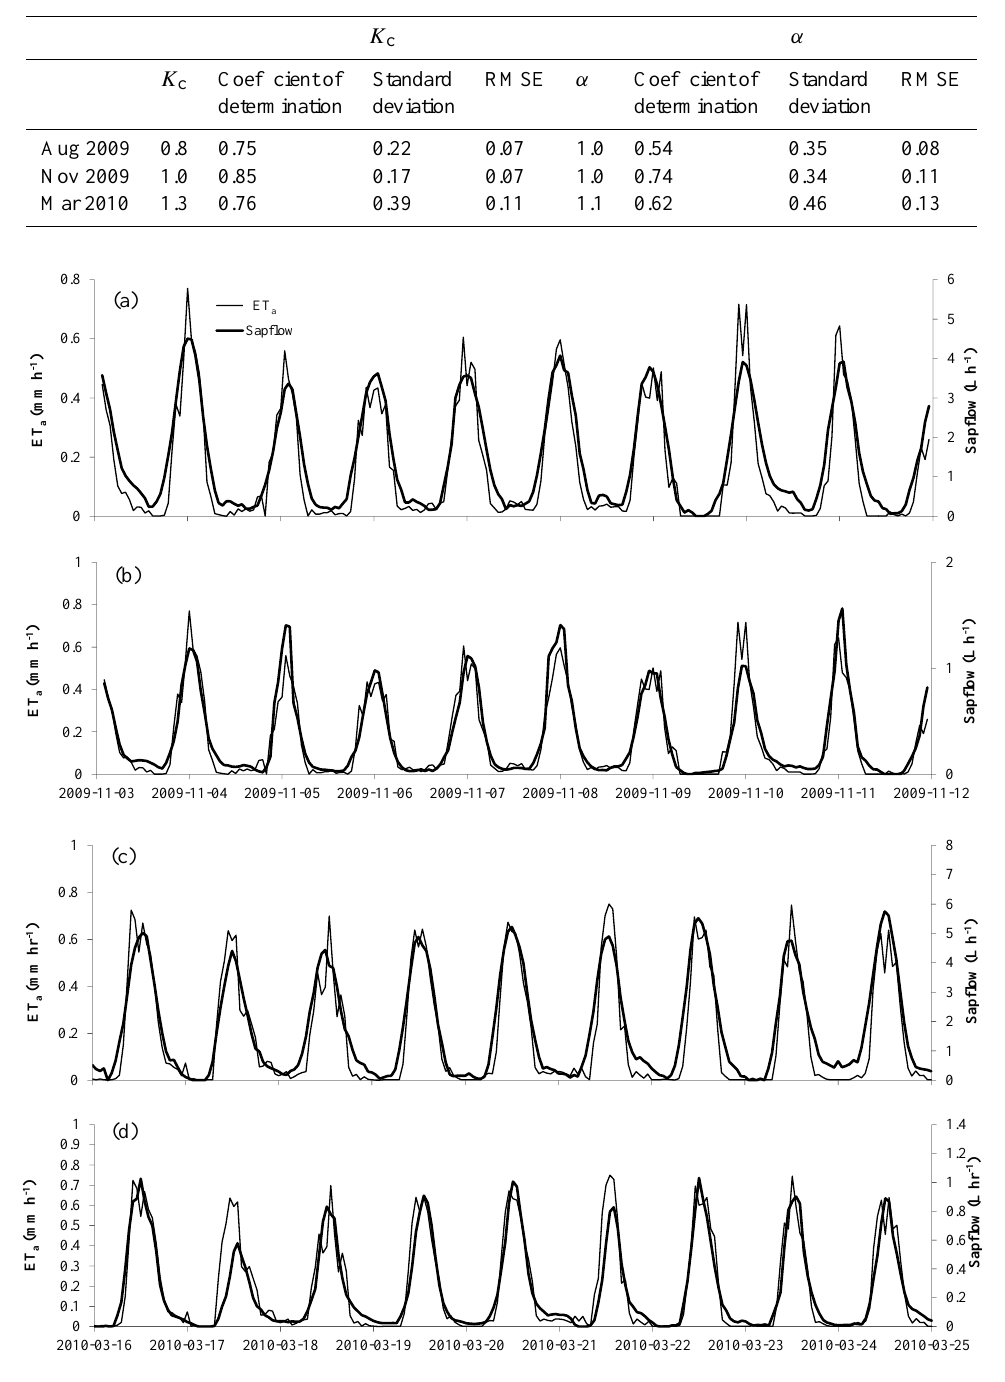
Figure 8. Diurnal course of the hourly actual total evaporation (ET a ) and sap flow in November 2009 ( a and b ) and March 2010 ( c and d ) for the emergent and understory trees,